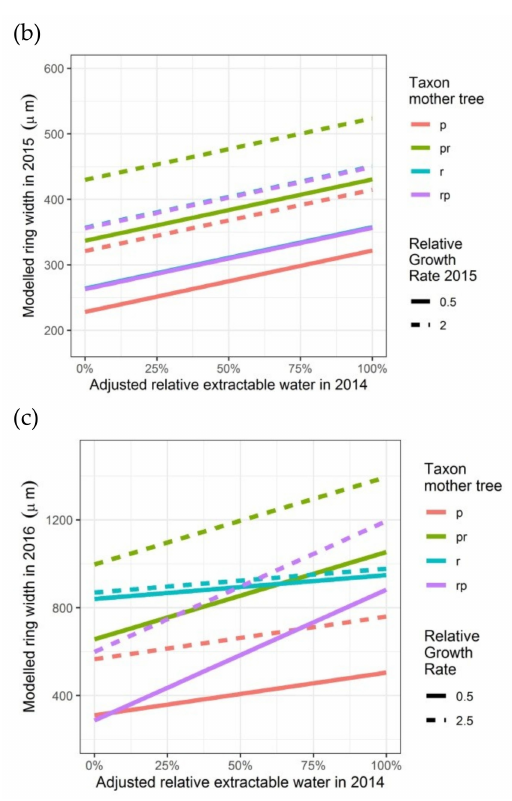
Figure 3. Modelled ring widths in the first three growing seasons (2014, 2015 and 2016), depending on the height of the seedlings in 2014 or on the relative growth rate in height (2015 and 2016), on the taxon of the mother trees and, only for 2015 and 2016, on the adjusted relative extractable water in 2014.